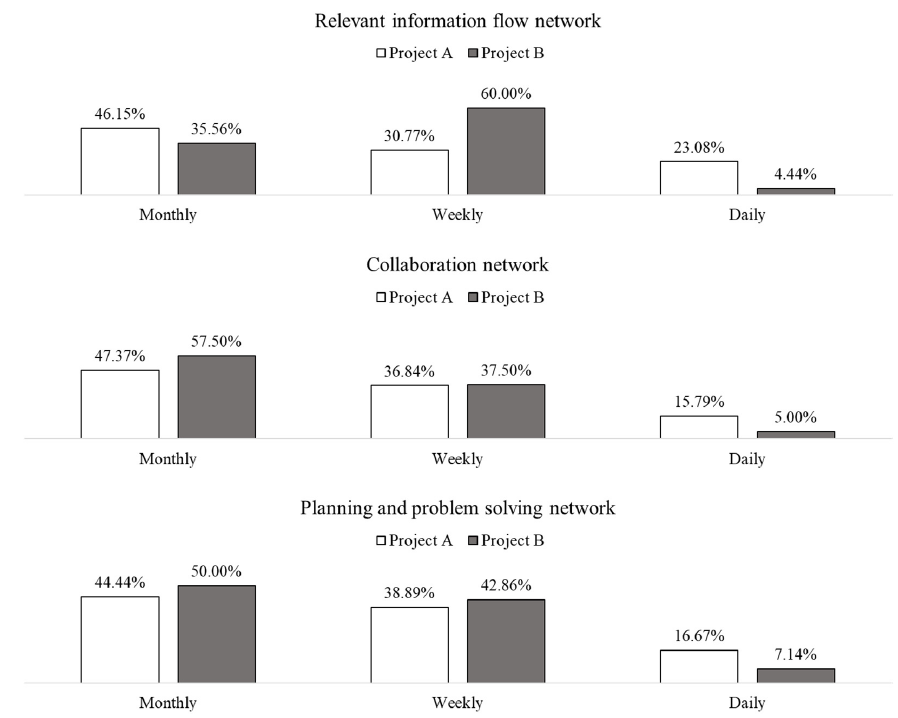
Figure 6. Density according to interaction frequency: Project A and project B.